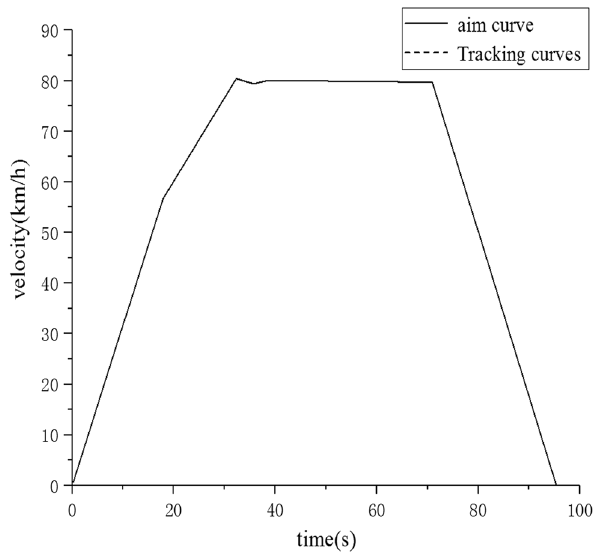
Figure 6: Ideal target curve and displacement tracking curve based on PID control.